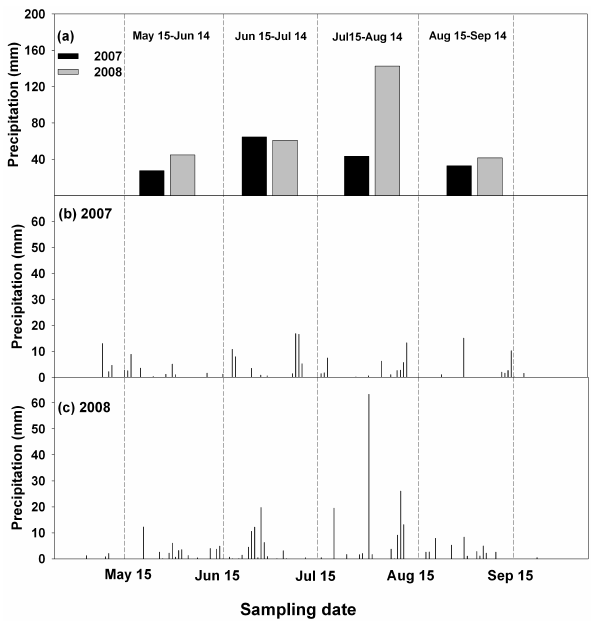
Fig. 1. Monthly (a) and daily precipitation during the growing sea- son in 2007 (b) and 2008 (c) . Dashed lines indicate sampling dates.